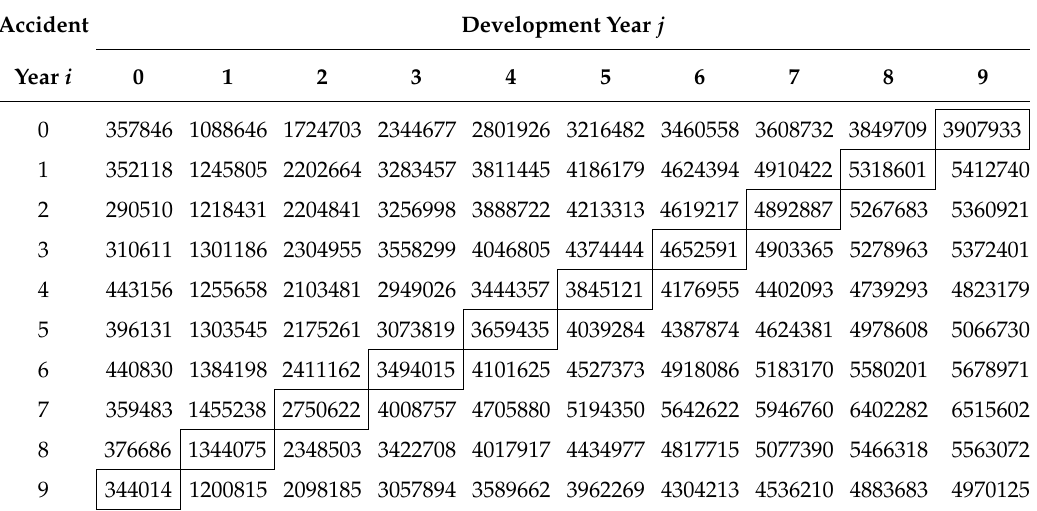
Table 3. Predictions (lower triangle), Filterings (last diagonal of upper triangle), Smoothings (upper triangle) for the data set of Taylor and Ashe